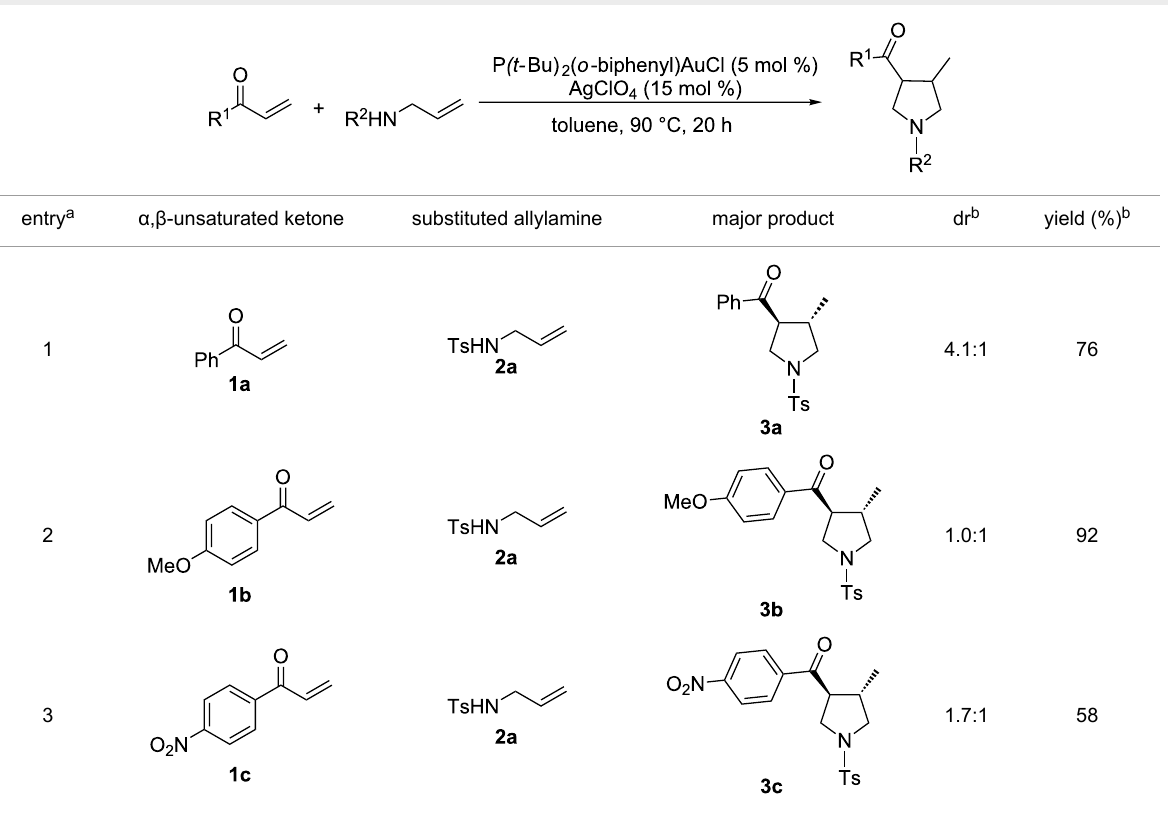
entry a α , β -unsaturated